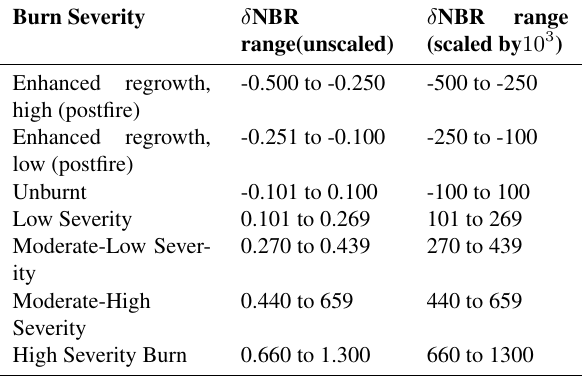
Table 2. Burn severity categories.